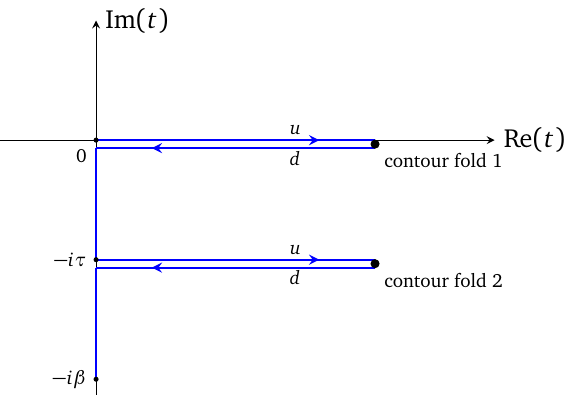
Figure 4: Keldysh contour with multiple contour folds. In this figure, we draw 2 contours, each fold consists of two sides (rails), upper ( u ) and lower ( d ) which are connected on the right end. We connect the different Keldysh contours on the left via imaginary time evolution, i.e. the state we start with is a thermal